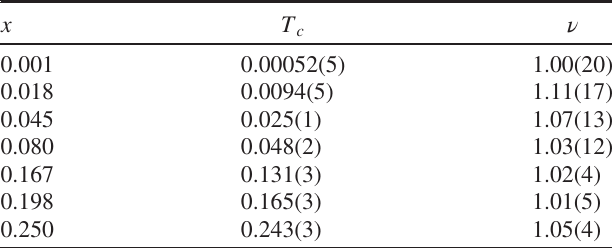
TABLE II. Critical temperature T c and critical exponent ν extracted from an extended scaling analysis for all studied concentrations x .